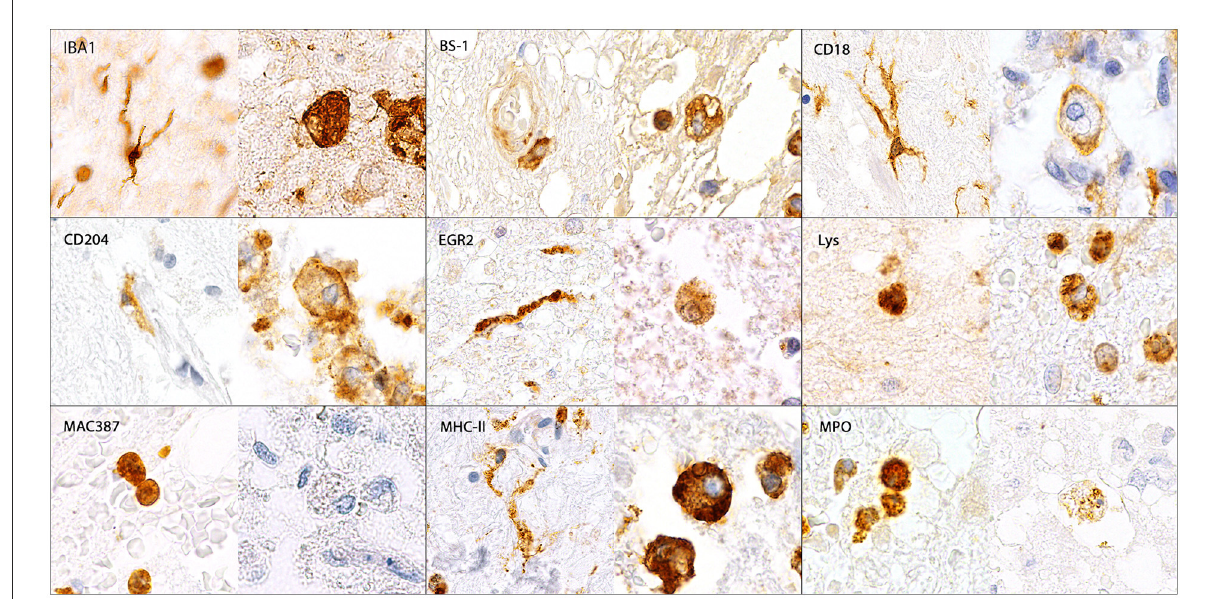
FIGURE5 Illustration of IBA1-, BS-1-, CD18-, CD204-, EGR2-, lysozyme (Lys)-, MAC387-, MHC-II- and myeloperoxidase (MPO)-immunopositive microglia/macrophages in the canine spinal cord. IBA1, CD18, CD204, EGR2 and MHC-II were expressed by ramified (arrows), rod-shaped (arrowheads), round, amoeboid and gitter cells (asterisks). In contrast, BS-1, Lys and MPO were only detected in round, amoeboid and gitter cells but not in ramified or rod-shaped microglia. MAC387 was only expressed by medium-sized round cells. Immunohistochemistry using the avidin-biotin complex immunoperoxidase